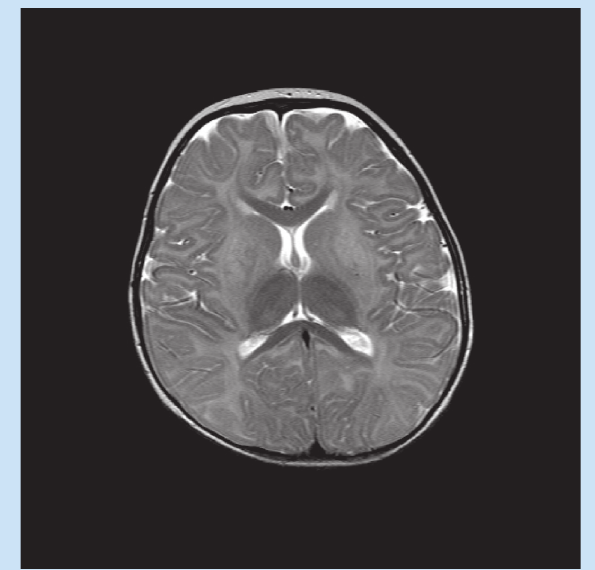
Fig. 1. Axial T2WI at the thalamic level demonstrating bilateral diffusely hypointense thalami, hyperintense speckled putamina, and delayed myelination.